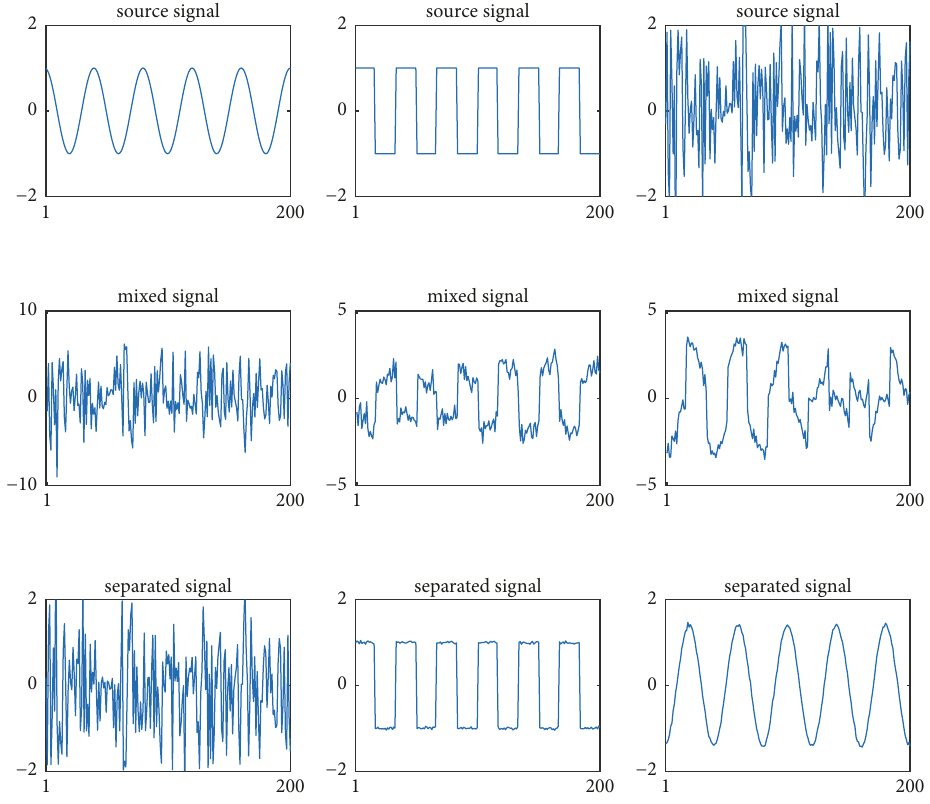
Figure 3: The decoupling of cosine signal and square wave signal with white noise.